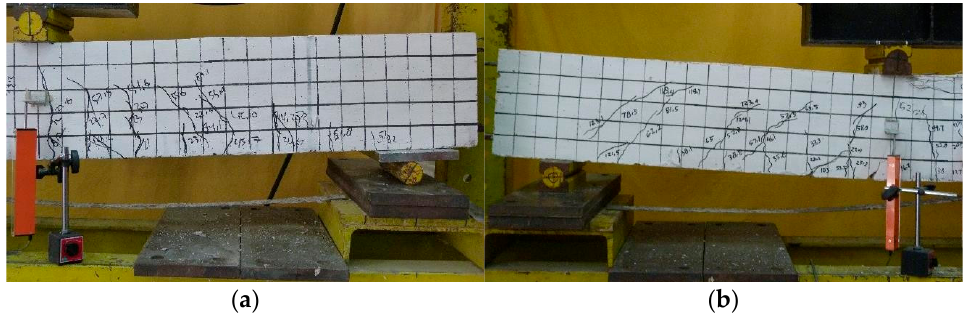
Figure 9. Debonding zone of beams with CFRP plates ( a ) G6P1, and ( b ) G6P2.